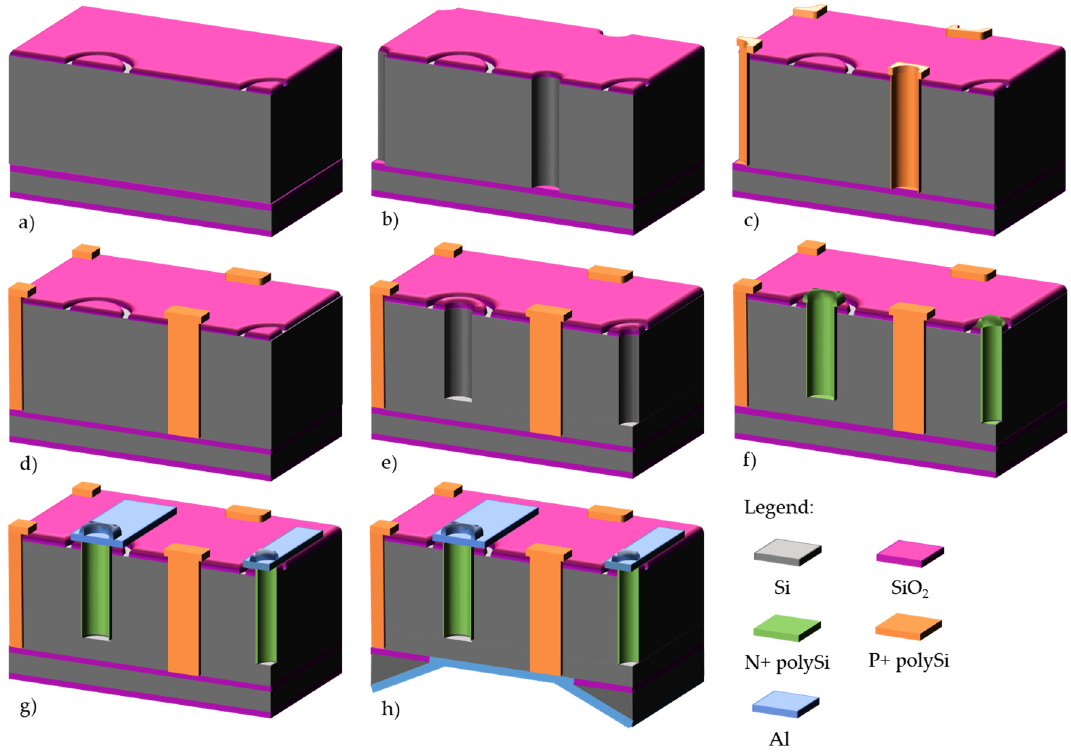
Figure 14. IMB-CNM 3D-SOI technology on SOI p-type wafers: ( a ) field oxidation and p-stop definition; ( b ) p + window patterning and DRIE of p + electrodes; ( c ) polysilicon deposition and p + doping; ( d ) sealing of p + electrodes with undoped polysilicon; ( e ) pattern and etching of n + window, and DRIE of n + electrodes; ( f ) polysilicon deposition and n + doping; ( g ) metal deposition and patterning on the front side; ( h ) support wafer etching with KOH from the backside and metallization. Fabrication of SOI wafers is done externally and therefore not included in the process.